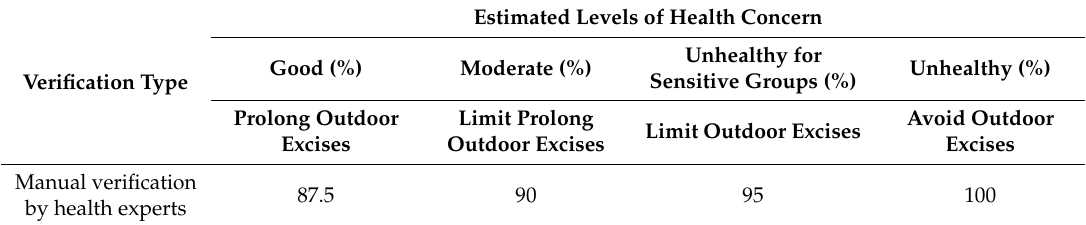
Table 4. Comparison of Different Verification Types.